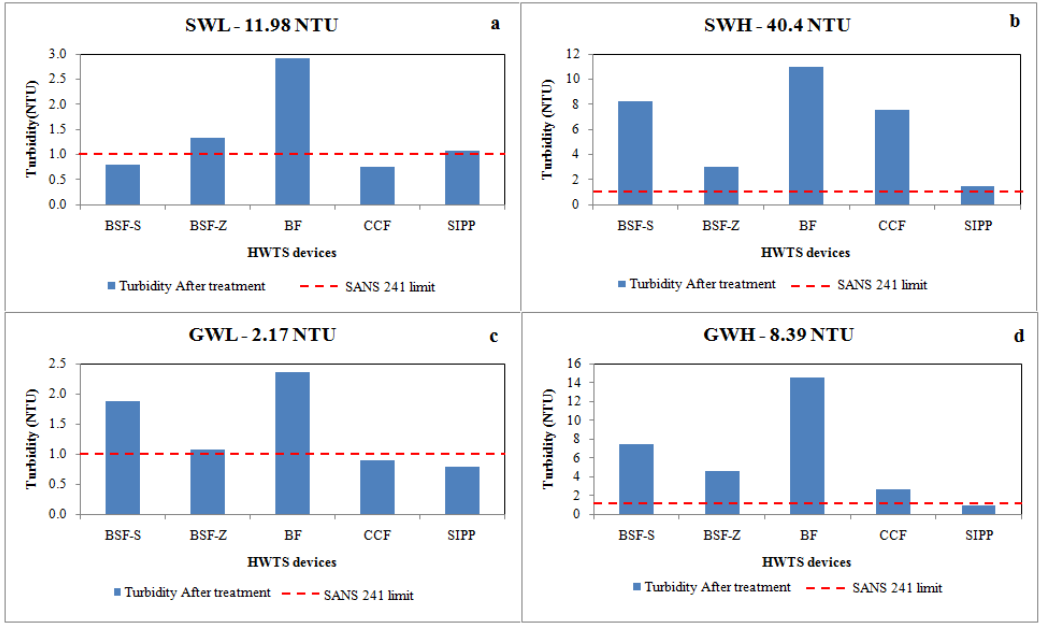
Figure 7. Turbidity removal by HWTS devices from each type of water source: ( a ) surface water with a low turbidity (SWL), ( b ) surface water with a high turbidity (SWH),